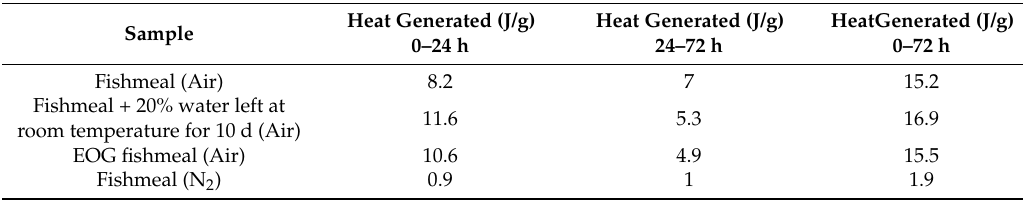
Table 5. Heat generated in fishmeal at 50 ◦ C.